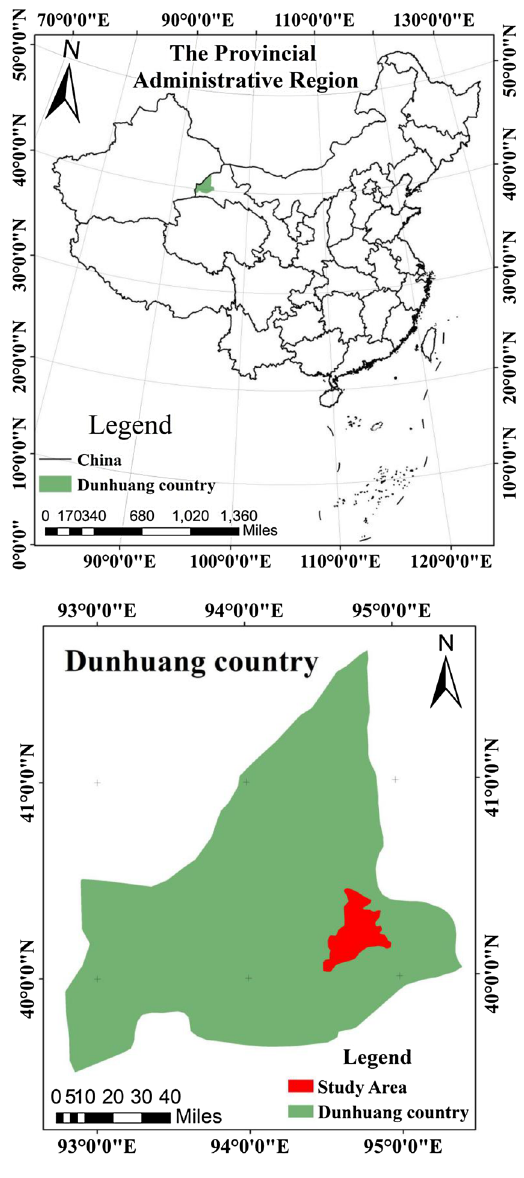
Fig. 1 Geographical position of study